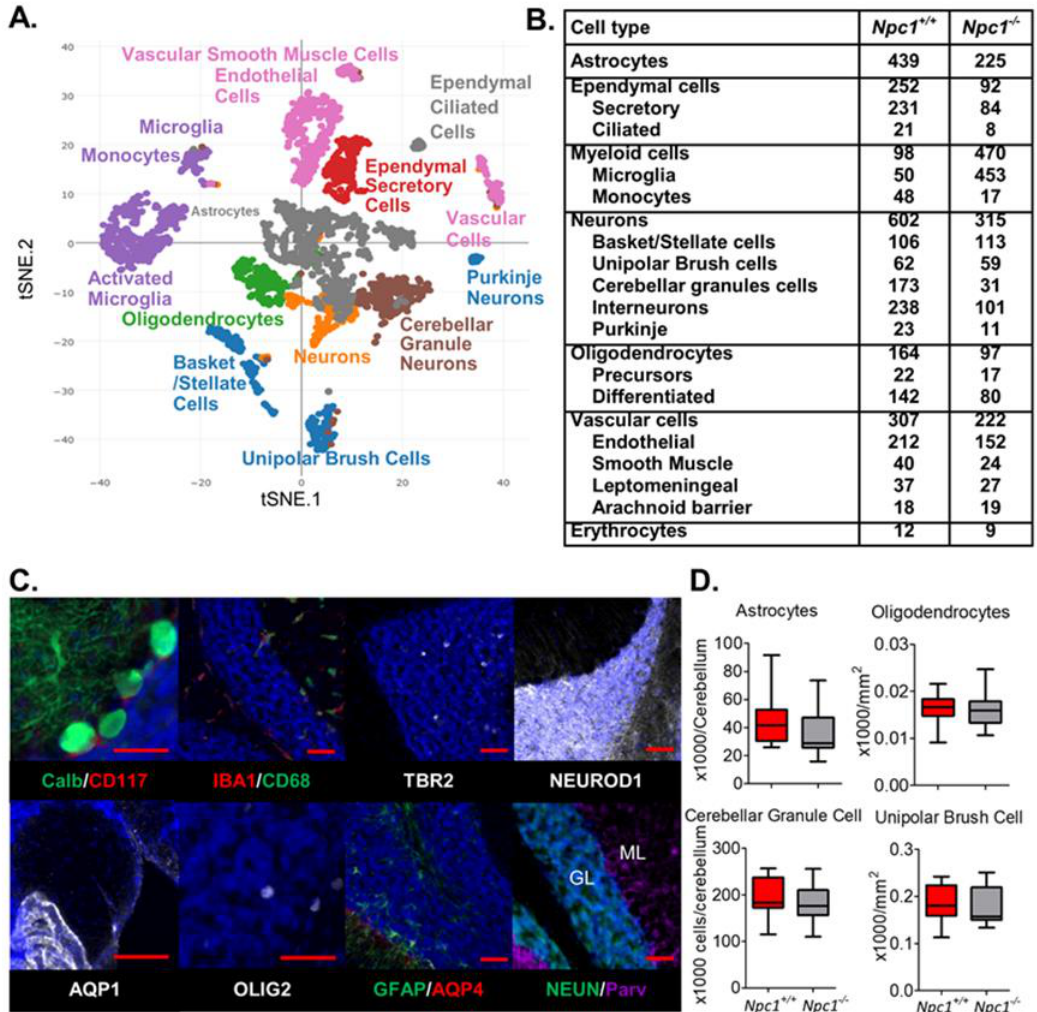
Figure 1. Identification of cerebellar cell populations. ( A ) Automatic K-means clustering was used to generate a t-SNE plot of single cell transcriptomes from Npc1 +/+ and Npc1 − / − cerebellar tissue at seven weeks of age. ( B ) Number of cerebellar cell type specific transcriptomes obtained from Npc1 +/+ and Npc1 − / − seven-week-old mice. ( C ) Representative immunostaining using antibodies corresponding to signature transcripts in seven-week-old mouse cerebella. Calb (Calbindin, Purkinje neurons); CD117 (basket / stellate neurons); IBA1 (microglia); CD68 (myeloid cells); TBR2 (unipolar brush neurons); NEUROD1 (cerebellar granule neurons); AQP1 (ependymal secretory cells); OLIG2 (oligodendrocytes); GFAP (astrocytes); AQP4 (astrocytes); NEUN (neurons); Parv (Parvalbumin, interneurons). Scale bar = 50 µ m. ( D ) Histopathological quantification of number of cerebellar granule neurons, oligodendrocytes, astrocytes, and unipolar brush cells in parasagittal sections of seven-week-old cerebella. N > 6.